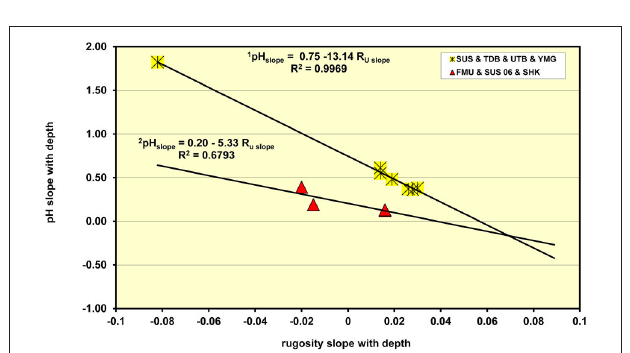
FIGURE 5 | Plot of the slope of the pH dependence on water depth and the dependence of rugosity on water depth which shows up the differences between sites that are undisturbed and those that have been subjected to “dynamite